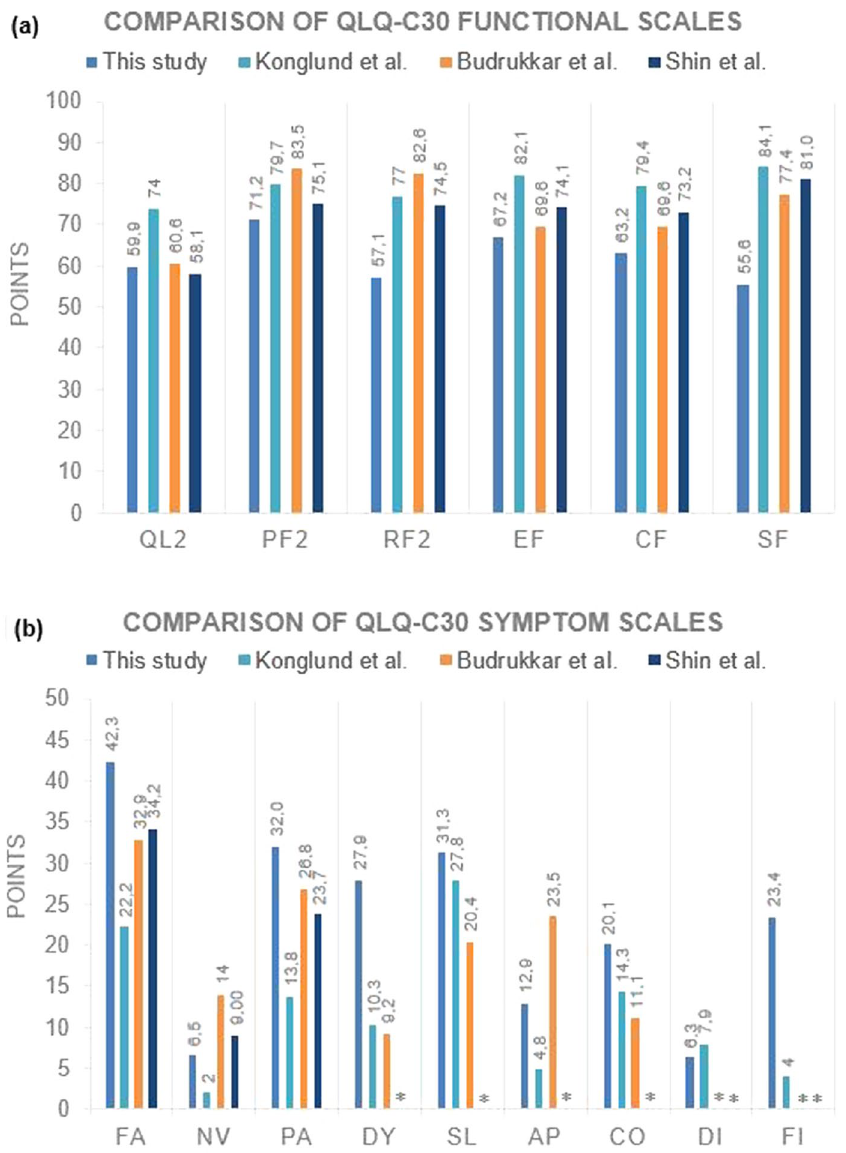
Figure 1. ( a ) Comparison of QLQ-C30 functional scales with previously published data. Higher scores in functional domains suggest higher level of functioning and better quality of life. QL2 = Global health status (revised); PF2 = Physical functioning (revised); RF2 = Role functioning (revised); EF = Emotional functioning; CF = Cognitive functioning; SF = Social functioning. ( b ) Comparison of QLQ-C30 symptom scales with previously published data. Higher scores in symptomatic domains suggest lower level of functioning and worse quality of life. Abbreviations: FA = Fatigue; NV = Nausea and vomiting; PA = Pain; DY = Dyspnea; SL = Insomnia; AP = Appetite loss; CO = Constipation; DI = Diarrhea; FI = Financial difficulties. *Data not